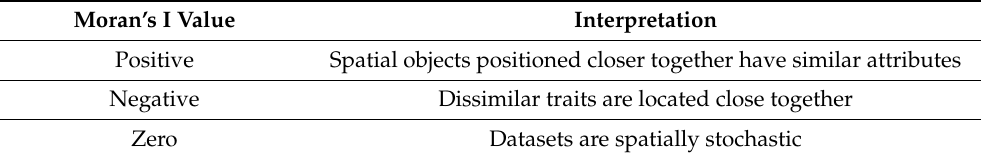
Table 5. Moran’s I value interpretation.